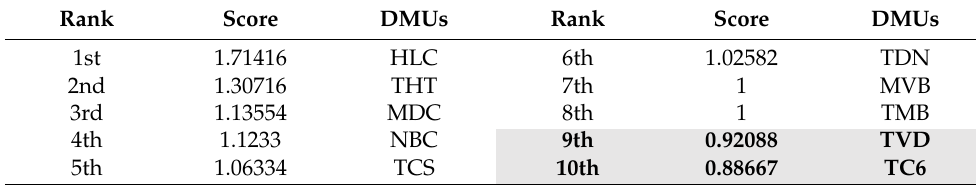
Table 8. Performance ranking of DMUs in 2021.